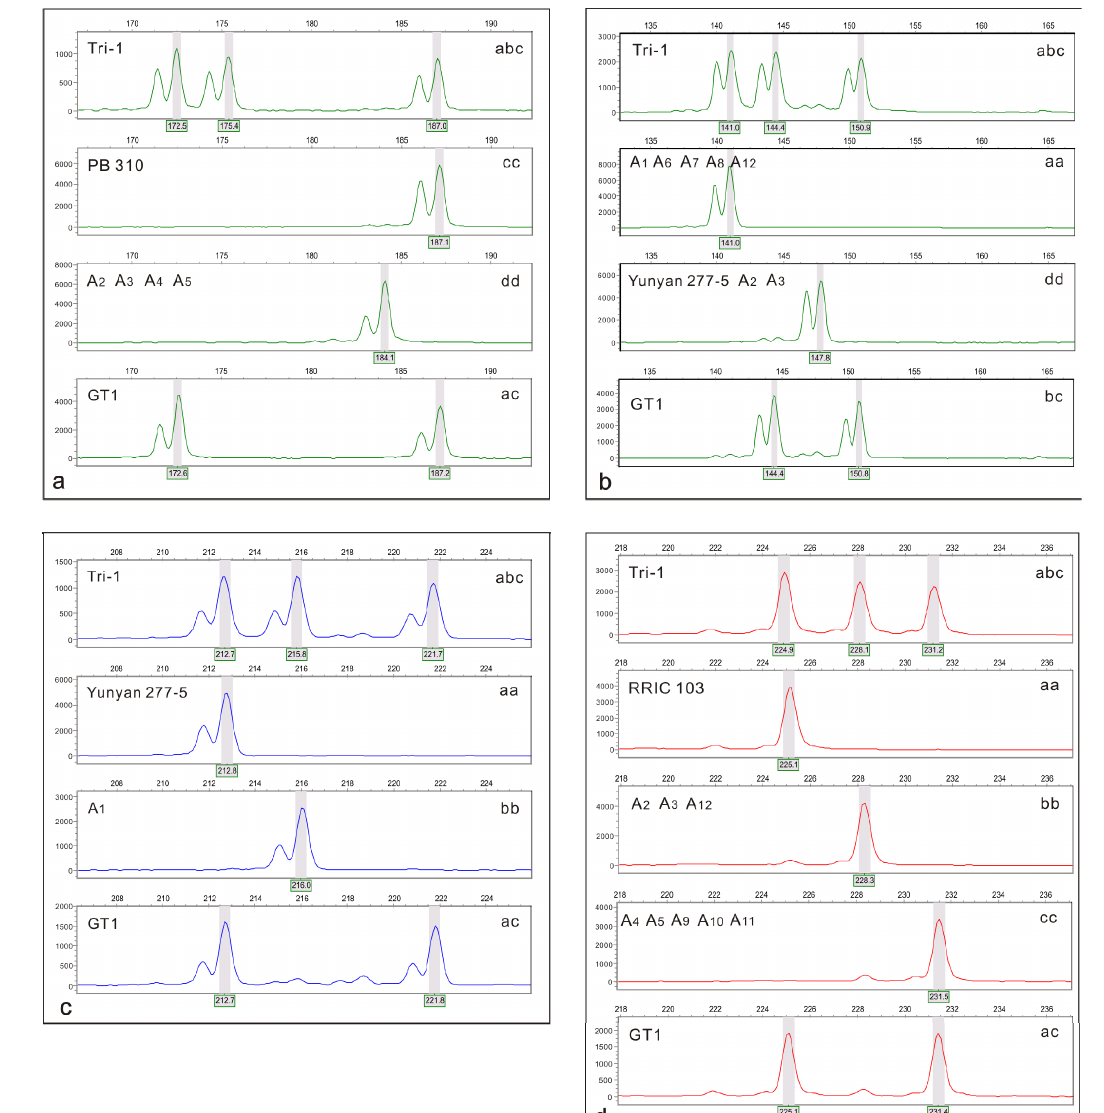
Figure 2. Alleles configurations of Tri-1, candidate male parents and GT1 for markers RUB 183, RUB 184, RUB 156 and RUB 199. ( a ) Marker RUB 183, alleles ‘abc’, ‘cc’, ‘dd’, ‘ac’ were amplified in Tri-1, PB 310, A 2 -A 5 and GT1 respectively; ( b ) Maker RUB 184, alleles ‘abc’, ‘aa’, ‘dd’, ‘bc’ were amplified in Tri-1, (A 1 , A 6 -A 8 , A 12 ), (A 2 , A 3 , Yunyan 277-5) and GT1 respectively; ( c ) Marker RUB 156, alleles ‘abc’, ‘bb’, ‘aa’, ‘ac’ were amplified in Tri-1, A 1 , Yunyan 277-5 and GT1 respectively; ( d ) Marker